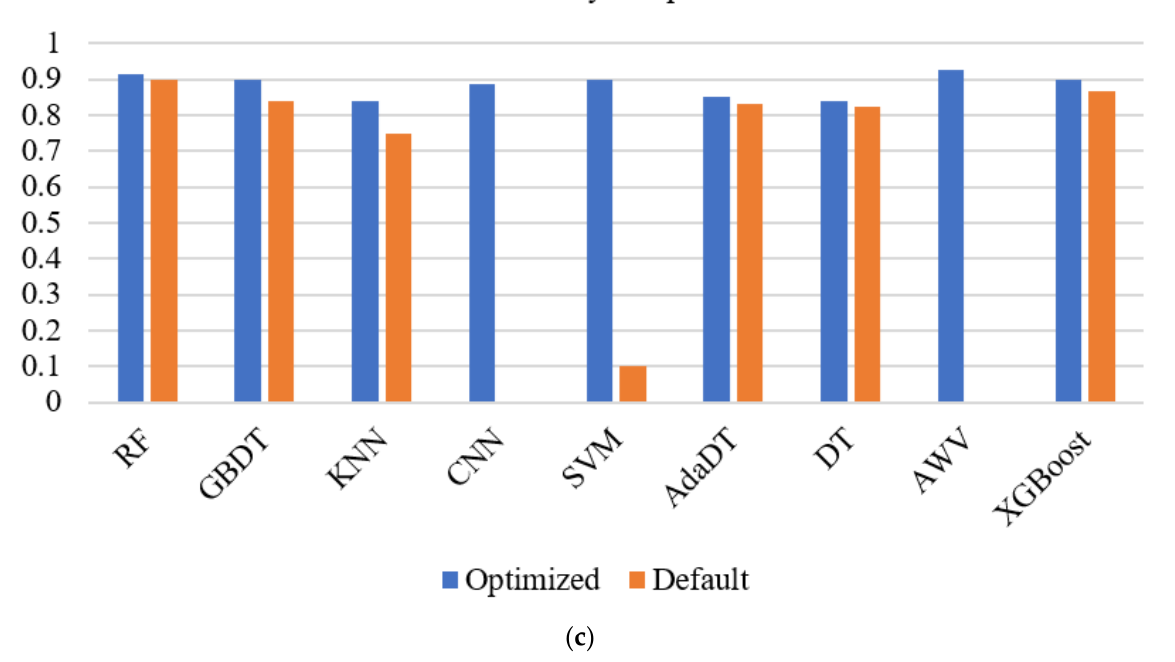
Figure 5. Proficiency comparisons of variables through applying 128 properties ( a ); ( b ) precision over 15 data sets through applying optimum variables; ( c ) mean accuracy comparison.